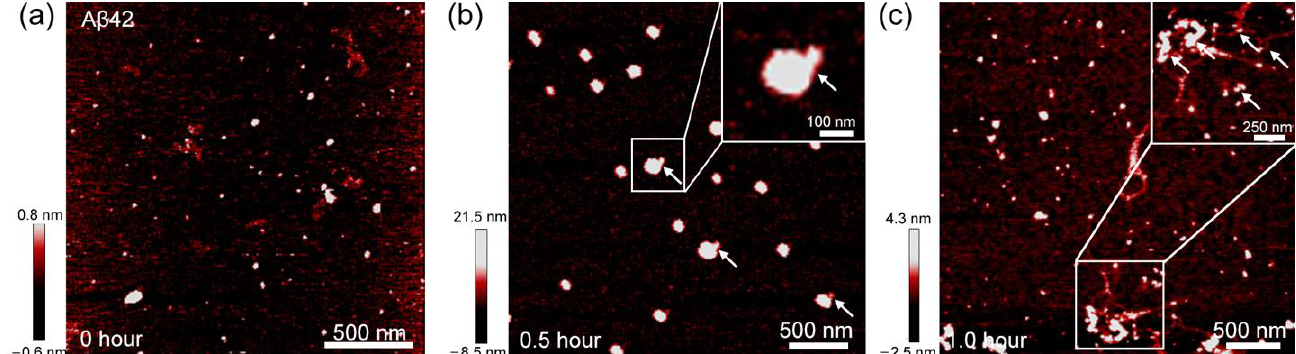
Figure 2. AFM images for Aβ42 aggregates that are formed under the incubation time of (a) 0 h, (b) 0.5 h, and (c) 1 h, respectively. The white arrows indicate the small spherical particle attached into large one.